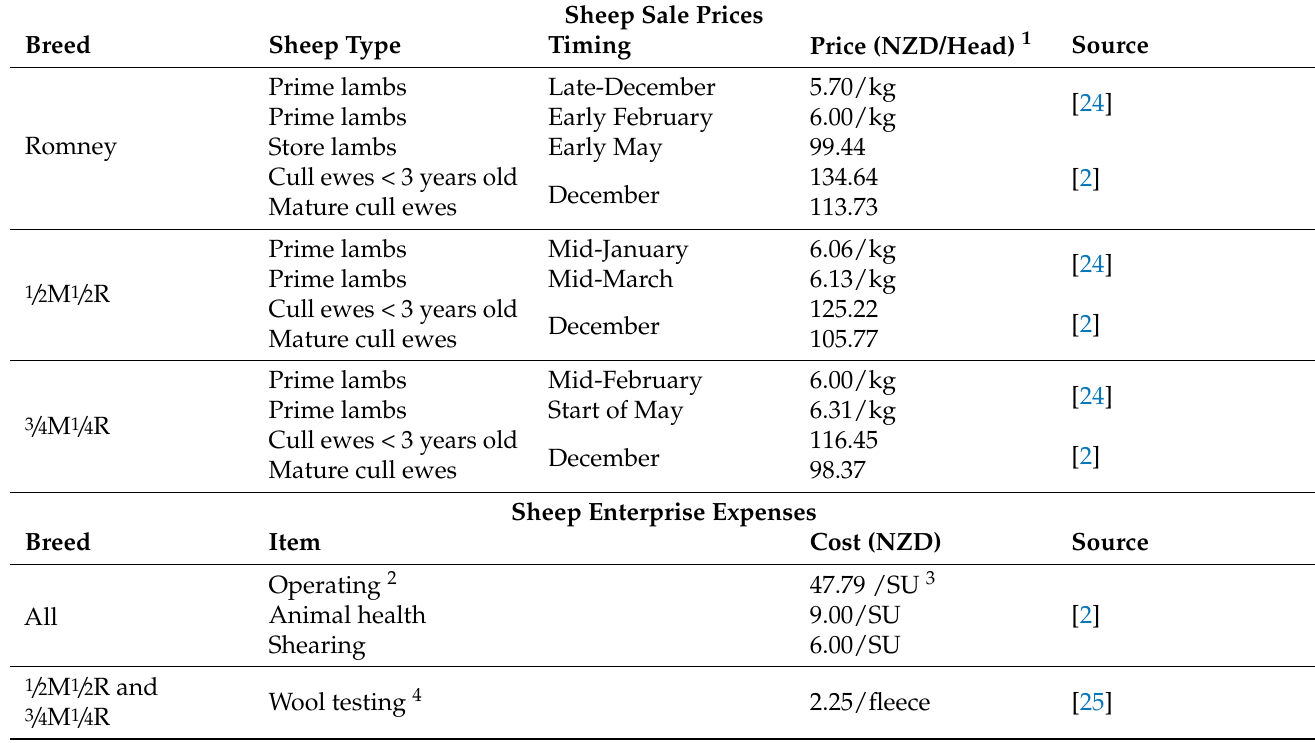
Table 4. Sheep sale prices and sheep enterprise expenses (in New Zealand Dollars) used in model for Romney, 1 / 2 Merino 1 / 2 Romney, and 3 / 4 Merino 1 / 4 Romney flocks. The base prices shown for sheep sales were also changed by ± 10% in a sensitivity